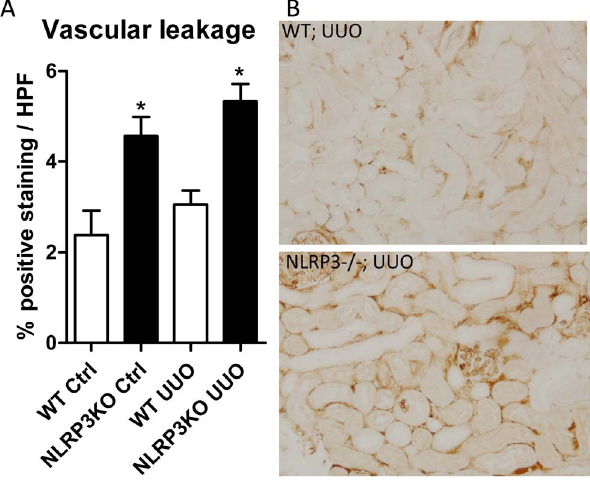
Figure 4. Nlrp3 deficiency elevates vascular leakage in the ligated and non-ligated kidney following UUO. (A) The accumu- lation of interstitial FITC-Dextran was significantly elevated in both obstructed (UUO) and contralateral (Ctrl) kidneys of Nlrp3 2 / 2 mice compared to wild type mice 1 day post-UUO. (B) Representative microphotographs of renal tissue subjected to 1 day UUO, demon- strating elevated interstitial FITC-Dextran accumulation in Nlrp3 2 / 2 obstructed kidneys (magnification 200x). Data are mean 6 SEM of 4 mice per group. *:p , 0.05.